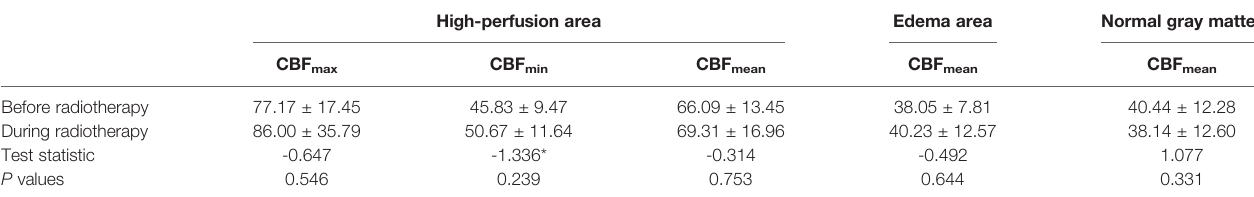
TABLE 4 | CBF values before and during radiotherapy (ml/100 g/min).